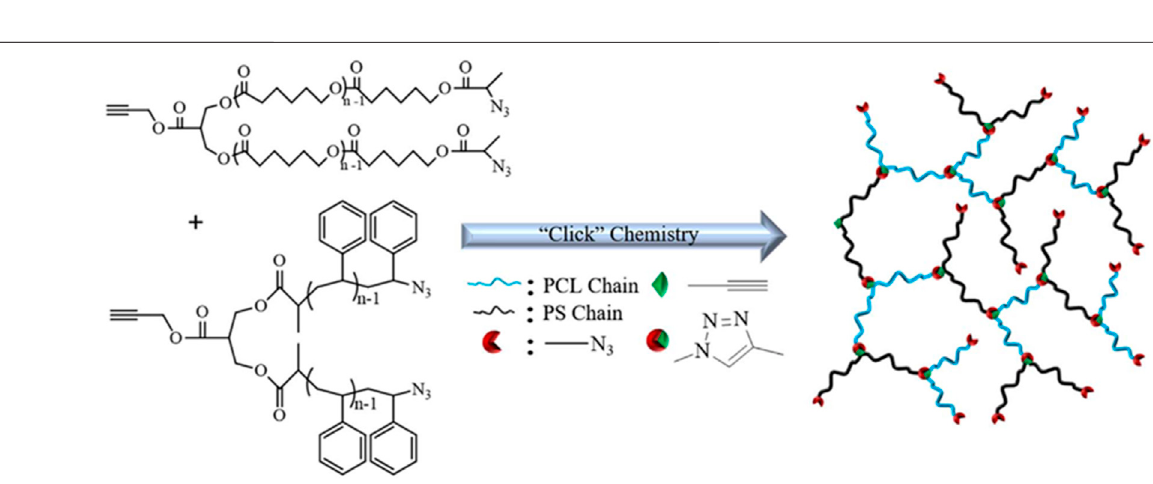
Frontiers in Energy Research |